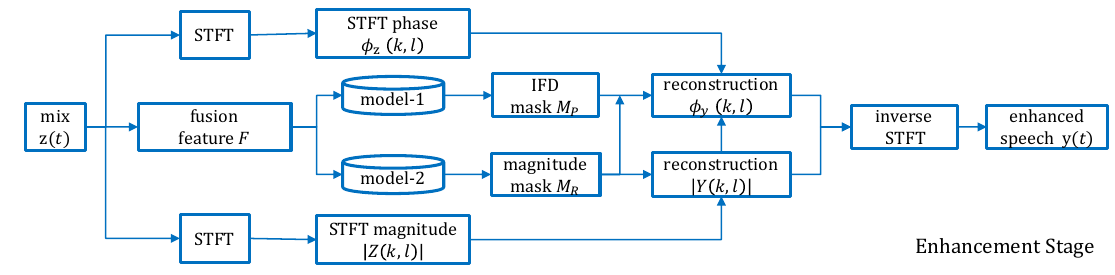
Figure 4. Speech enhancement scheme of the proposed